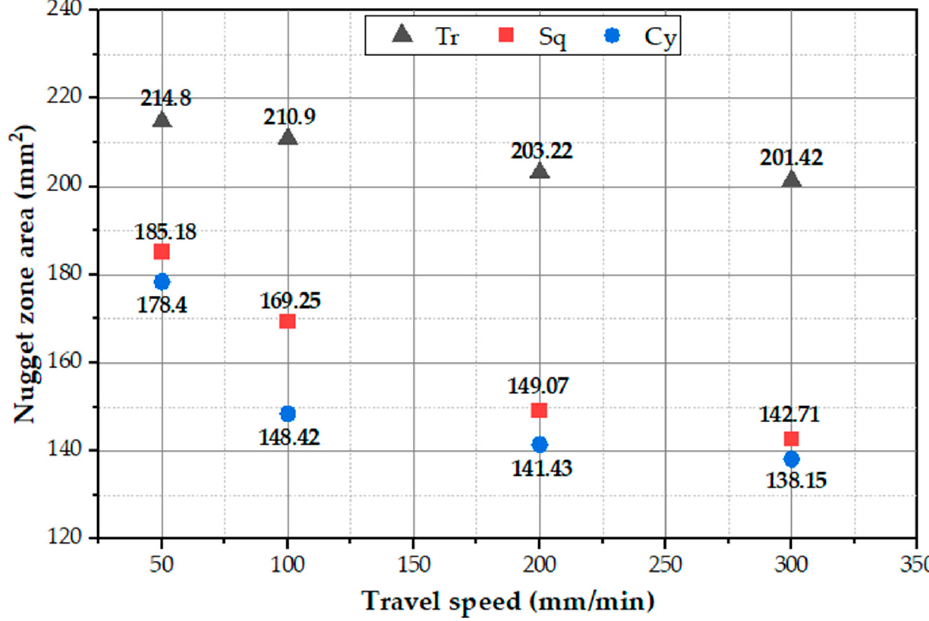
Figure 16. Processing zone area of the AA1050 BT-FSPed at travel speeds of 50, 100, 200, and 300 mm/min using Tr, Sq, and Cy pin geometries.